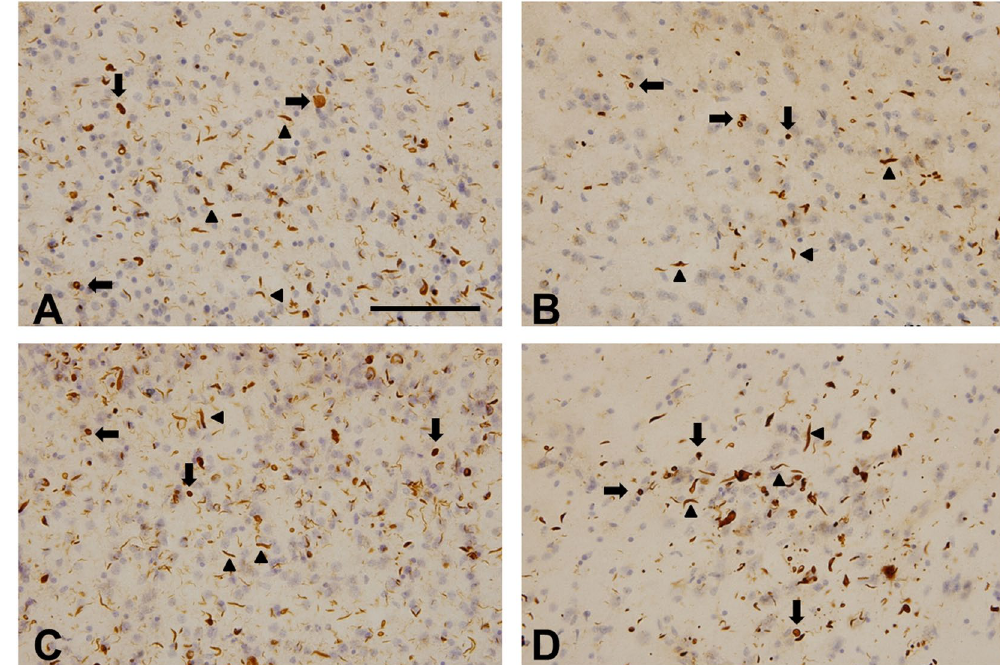
Figure 1. Immunohistochemical staining of the temporal lobe of GRN mutation cases with antibody to phosphorylated TDP-43. Numerous neuronal cytoplasmic inclusions (arrows) and dystrophic neurites (arrowheads) were stained with anti-TDP-43-pS409/410 antibody in cases 1 ( A ), 2 ( B ), 3 ( C ) and 4 ( D ). The sections were counterstained with hematoxylin. The scale bar in ( A ) applies to all photomicrographs (100 μ